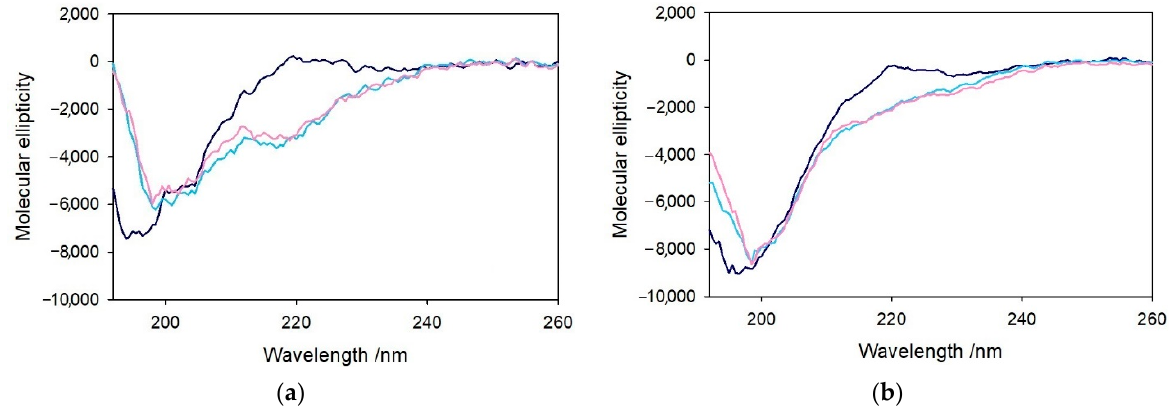
Figure 8. Far-UV CD spectra of 1.1 equiv. A β 4–16 peptide (10 µM, panel a ) and 1.1 equiv. A β 4–28 peptide (5.5 µM, panel b ) in 5 mM phosphate buffer solution at pH 7.4 (blue traces) and upon the addition of copper(II) (1 equiv., light blue) and DA (1 equiv., pink).